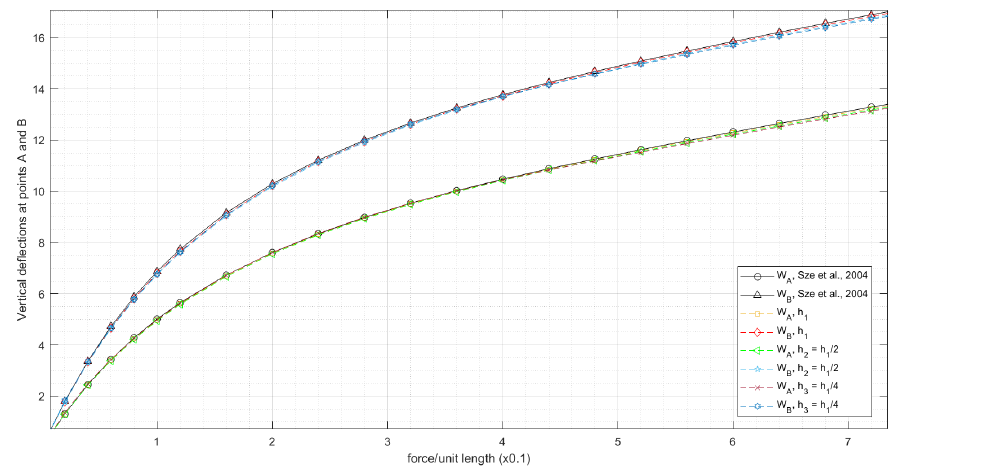
Figure 6. Load–deflection curves for the slit annular plate lifted by line force P . W A and W B are the vertical tip deflections of points A and B , respectively.